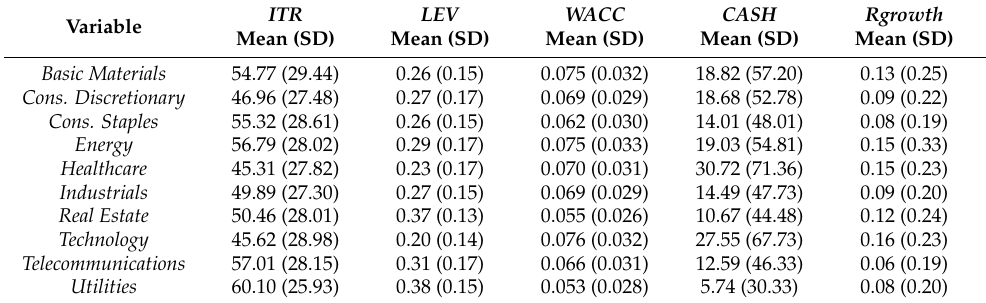
Table 4. Descriptive statistics per industry.